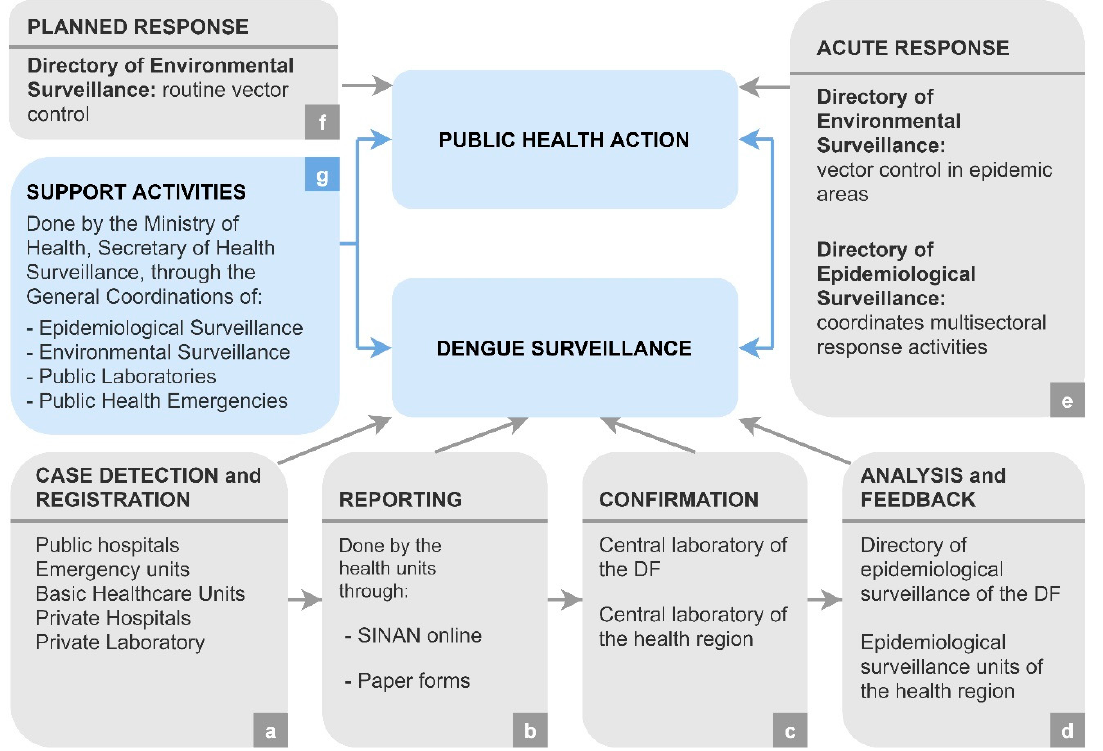
Figure 1. System map of dengue surveillance in the Federal District (Brazil). Suspected cases of dengue are identified and notified from the healthcare units ( a ) through the online portal or paper forms ( b ). Laboratory confirmation is conducted by the Central Laboratory of Public Health ( c ), and the data are analyzed by the Directory of Epidemiological Surveillance ( d ). The Directory of Epidemiological Surveillance is also responsible for response activities ( e ), along with the Directory of Environmental Surveillance, which conducts vector control ( e,f ). The model also shows support activities, which are conducted by the Ministry of Health ( g ).